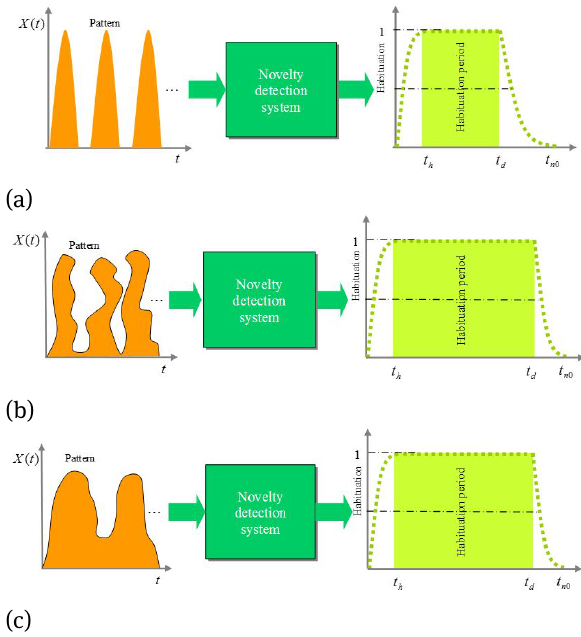
presentation of repeated patterns that generates standard ha- bituation; (b)-(c) presentation of complex patterns prolongs habitu-